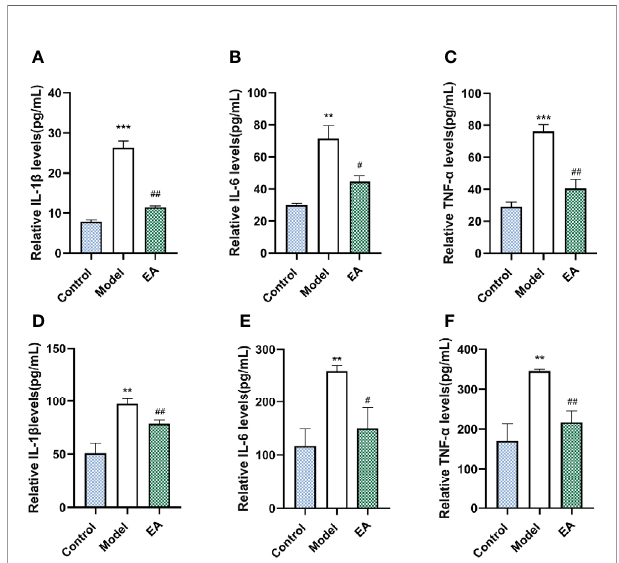
FIGURE 4 | EffectofEAontheexpressionofIL1 b ,IL6,andTNF- a inthefootpad skinandthe sciaticnerve.RelativelevelsofIL1 b (A) ,IL6 (B) , andTNF- a (C) of footpadskininthecontrol, model,andEAgroup(n= 4, **p<0.01,***p<0.001, # p<0.05, ## p<0.01). Relativelevels ofIL1 b (D) ,IL6 (E) , andTNF- a (F) offootpad skininthecontrol,model, andEAgroup(n=3,**p<0.01, # p<0.05, ## p<0.01).